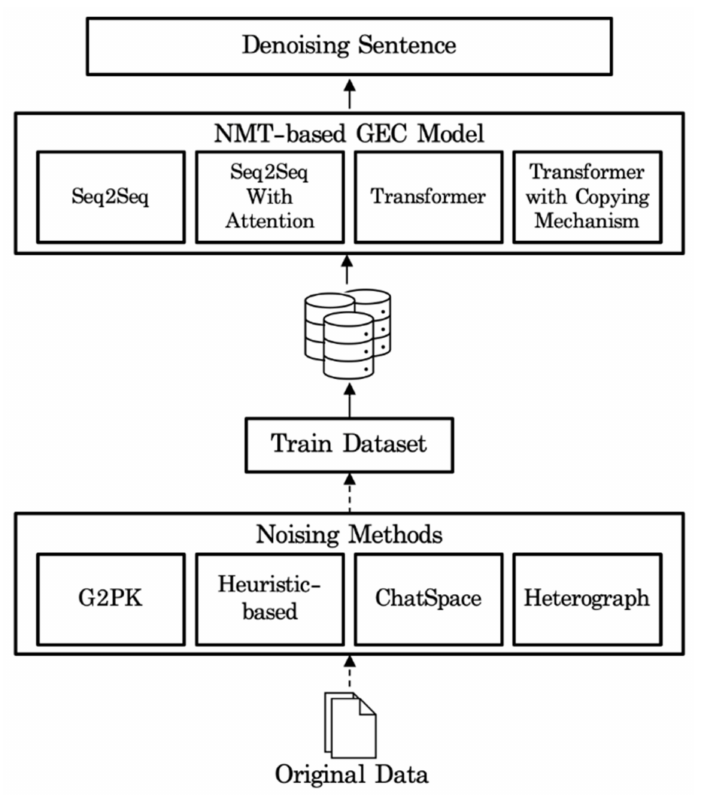
Figure 2. Method Pipeline. NMT, Neural Machine